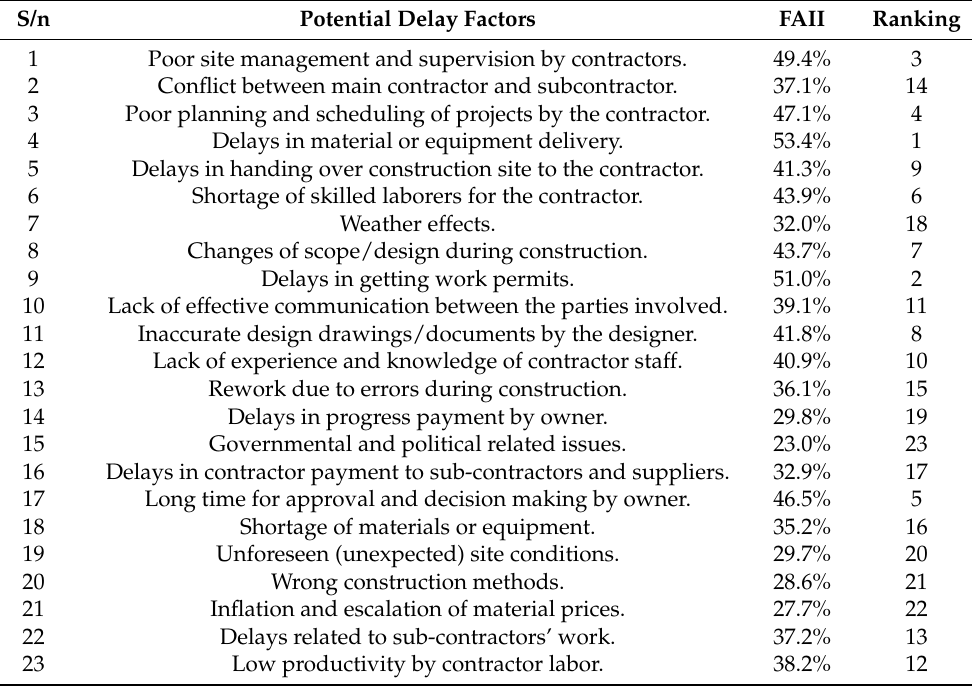
Table 6. The Frequency Adjusted Importance Index (FAII)